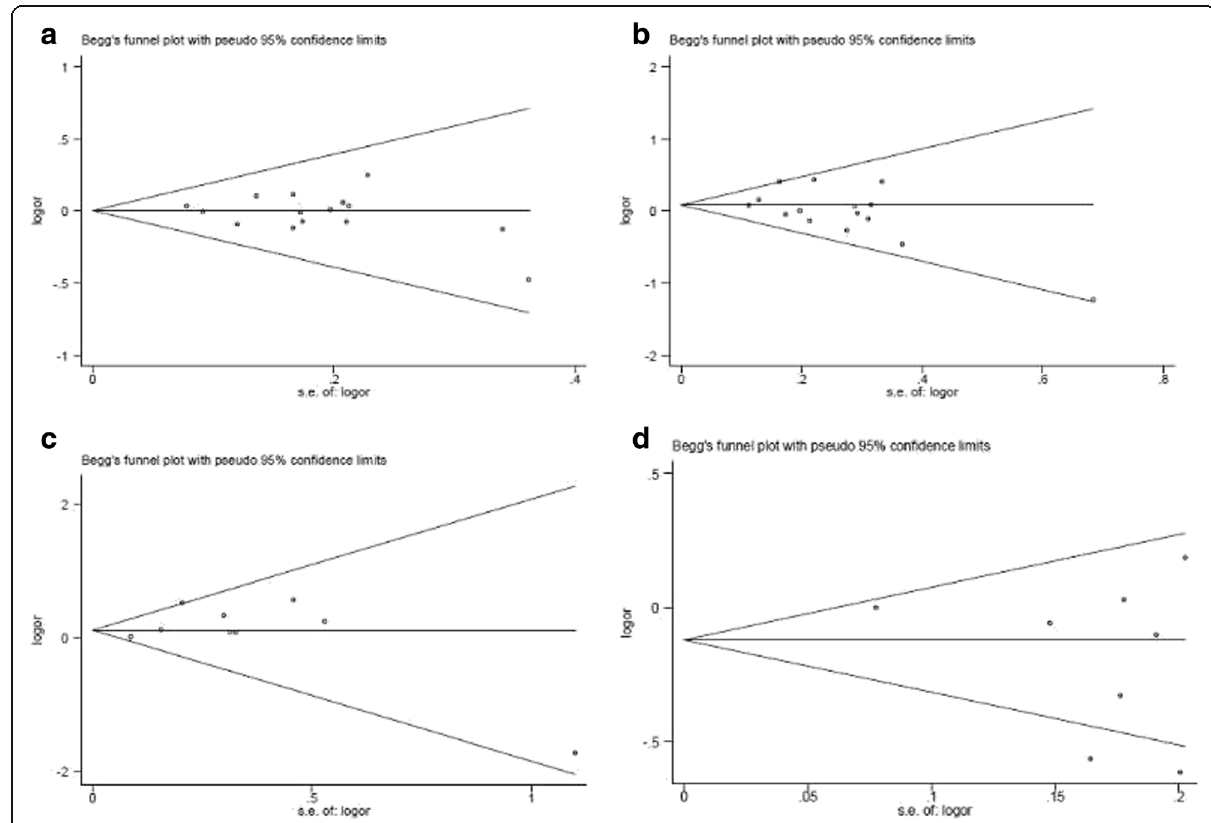
Fig. 5 Publication bias A: GSTM1-null genotype; B: GSTT1-null genotype; C: dual null genotype for GSTM1/GSTT1; D: GSTP1 A/G gene polymorphism. Each point represents a separate study for the indicated association. Log or represents natural logarithm of OR. Vertical line represents the mean effects